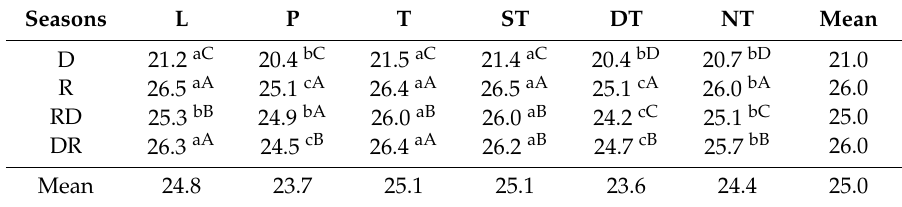
Table 2. Average soil water content (SWC w / w − 1 ) at 0–40 cm depth in four di ff erent type of seasons and at six soil tillage